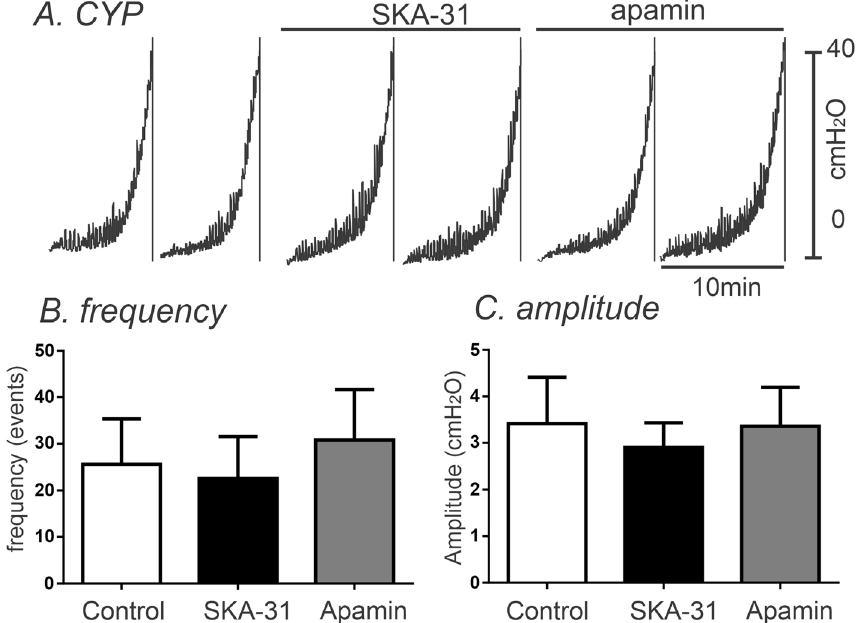
Figure 7. The Effect of SK channel activator and blocker on TCs in the ex vivo volume-preparation from CYP- treated bladders. ( A ) Ex vivo compliance curves for control, SKA-31 and apamin application from